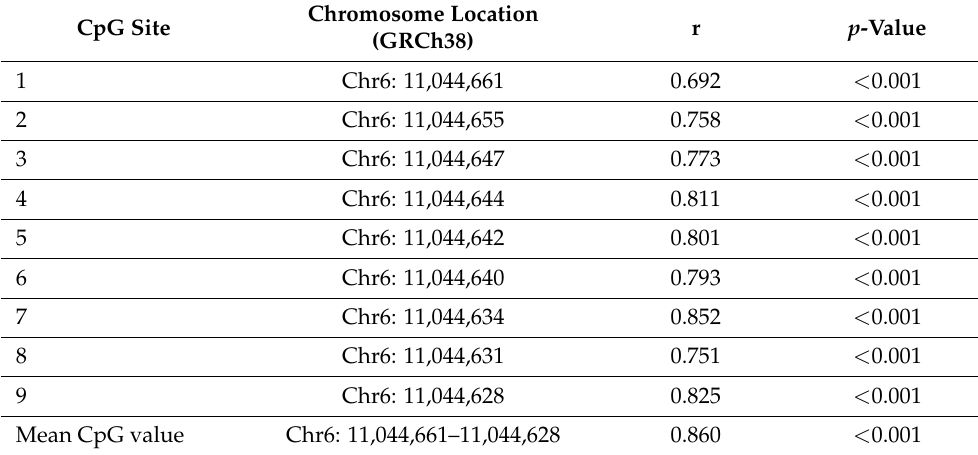
Table 2. Correlation values between the 9 CpG sites of ELOVL2 , their average value, and the age at the recruitment of the analyzed